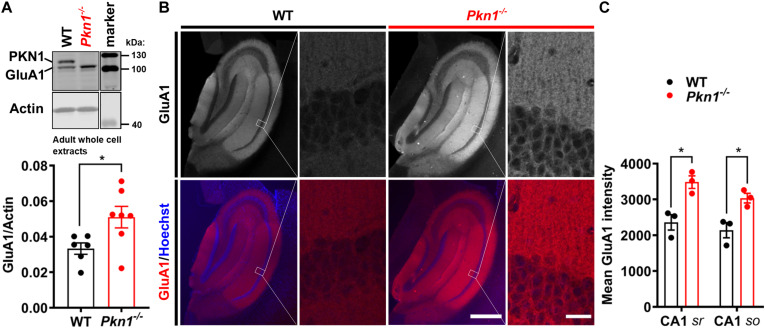
Adult Pkn1–/– animals have enhanced GluA1 protein levels (A) Whole cell protein extracts from adult WT and Pkn1–/– hippocampi were prepared, probed for GluA1 and the ratio to the loading control actin was calculated (*P = 0.0321, unpaired t-test). The marker in the representative blot is shown in a separate lane as samples were not directly next to the marker in the blot. (B) Hippocampal GluA1 levels were further assessed by immunofluorescence staining. Pictures are representative of 3 animals/genotype. Scale bar in overview images refers to 500 μm and scale bar in high resolution inserts refers to 20 μm. (C) The mean intensity of hippocampal GluA1 levels from (B) was quantified in Fiji. CA1 sr refers to CA1 stratum radiatum, CA1 so refers to CA1 stratum oriens. (CA1 sr *P = 0.0156, unpaired t-test, CA1 so *P = 0.0233, unpaired t-test). All data is presented as individual n-values with mean ± S.E.M.